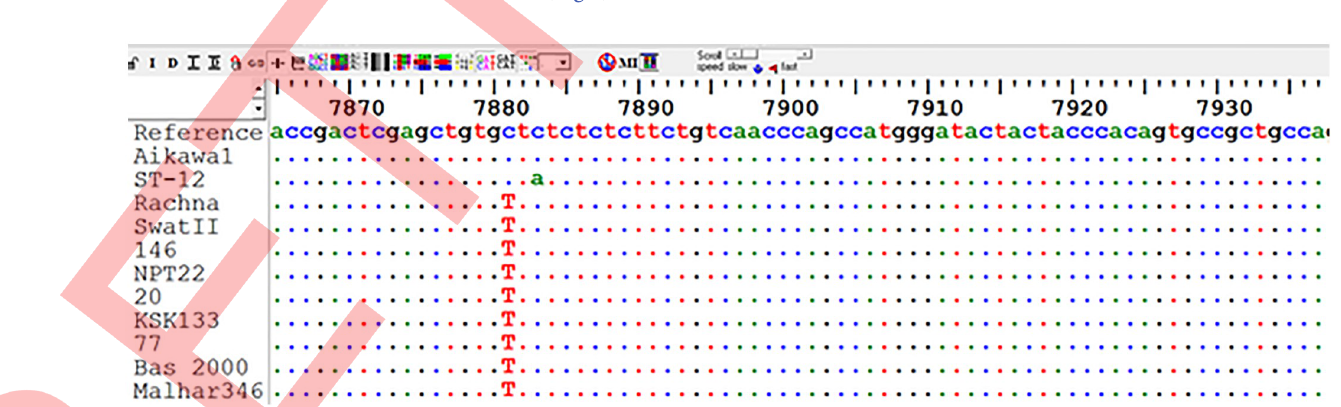
Fig 3. Aikawa1 and ST-12 are the two control sequences along reference genome (Nipponbare).